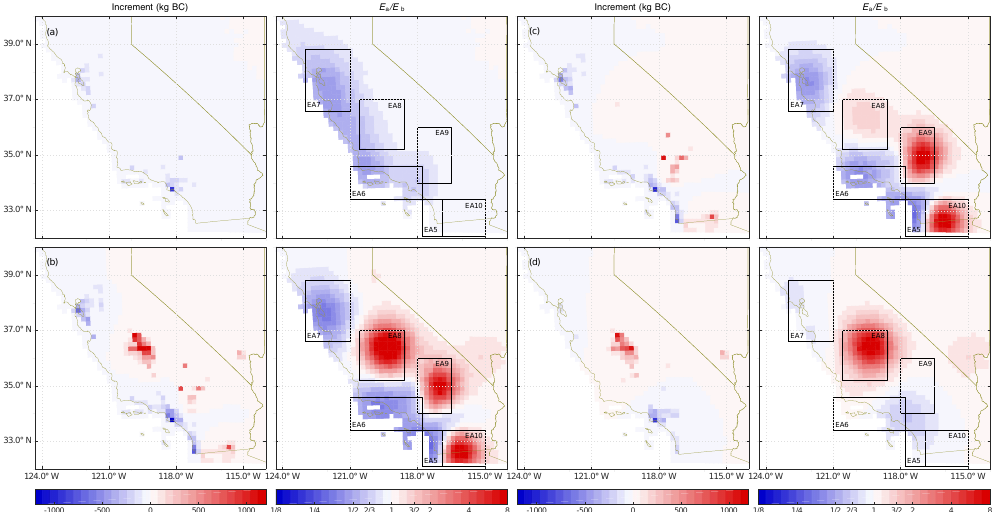
Figure 11. Anthropogenic analysis increment (posterior minus prior) per 24h and posterior linear scaling factor ( β ) for the (a) FINN_STD (22), (b) FINN_STD (23/24), (c) ACFT, and (d) SURF inversion scenarios. EA5–9 are outlined with black boxes in the scaling factor